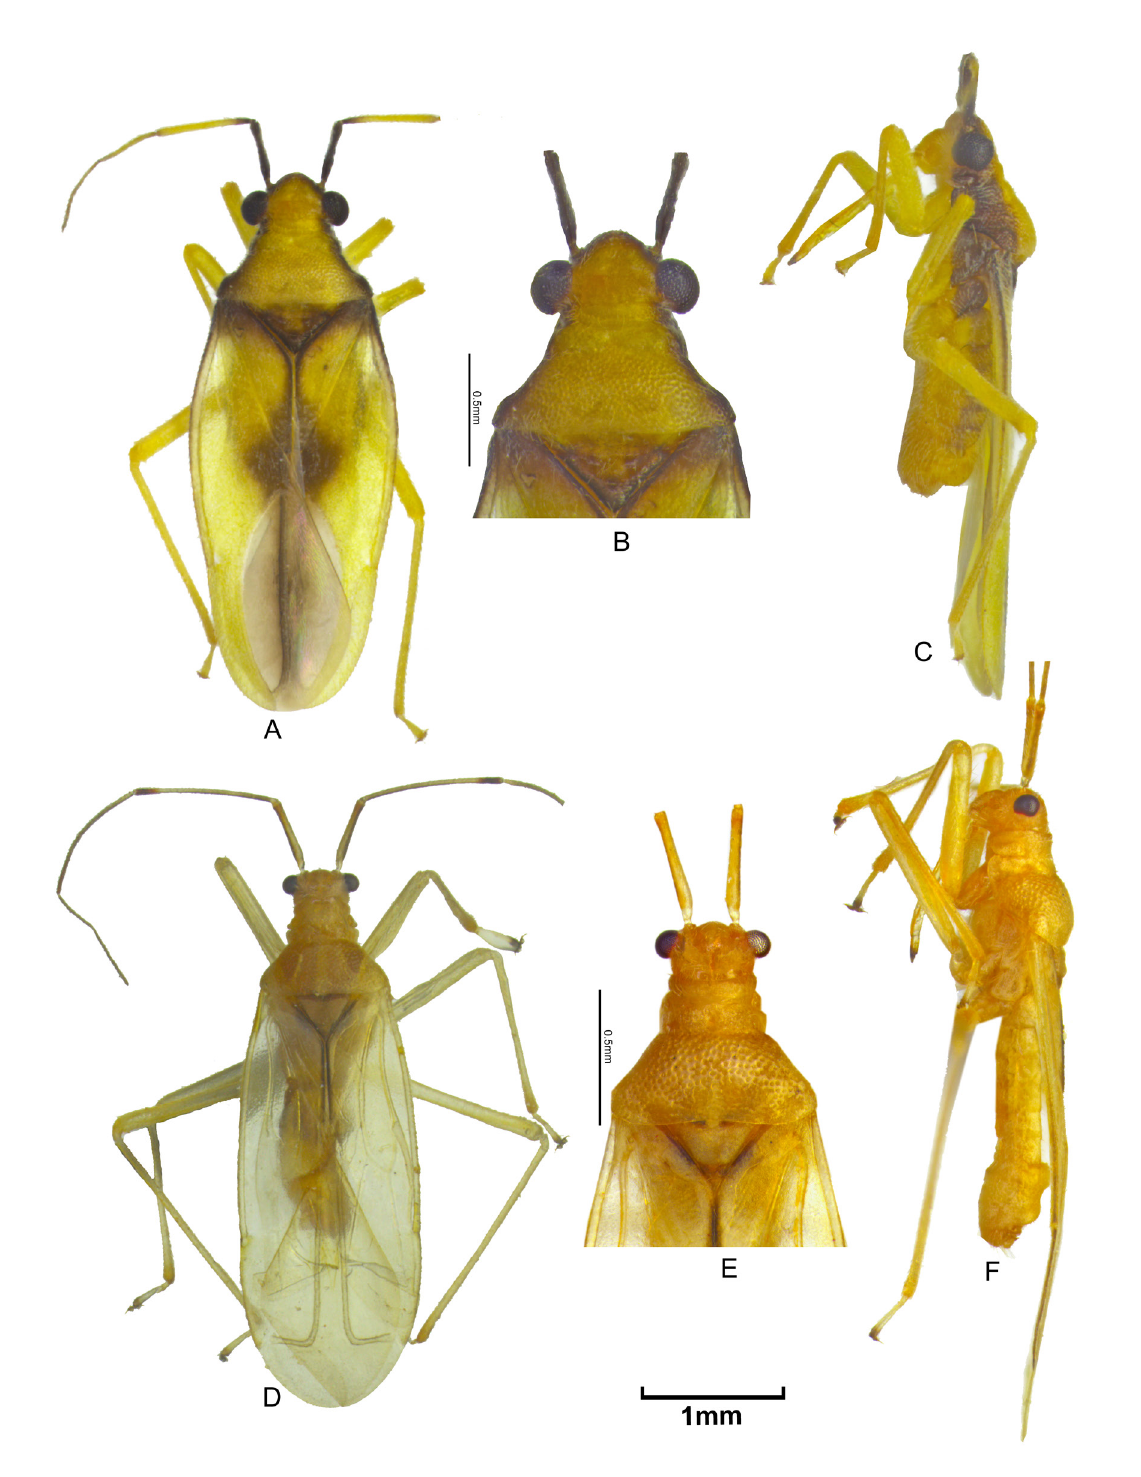
Fig. 4. Habitus of Namyatovia gen. nov. and Stonedahlia gen. nov. spp. A–C . Namyatovia sirsiensis gen. et sp. nov., ♂, UASB. A . Dorsal view. B . Head and pronotum. C . Lateral view. D–F . Stonedahlia mishmiensis gen. et sp. nov., ♂, UASB. D . Dorsal view. E . Head and pronotum. F . Lateral